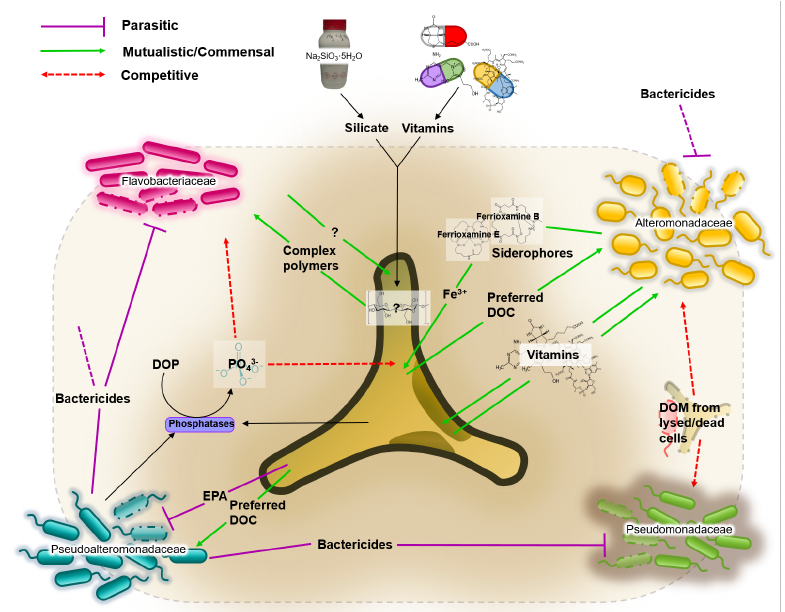
Figure 3. Network of putative interactions between Phaeodactylum tricornutum and identified bacterial families. The dotted grey line depicts the “phycosphere”; a term coined by Bell and Mitchell in 1972 as an aquatic equivalent of the “rhizosphere”, denoting the region extending outwards from the algal cell in which bacterial growth is stimulated by extracellular products of the alga